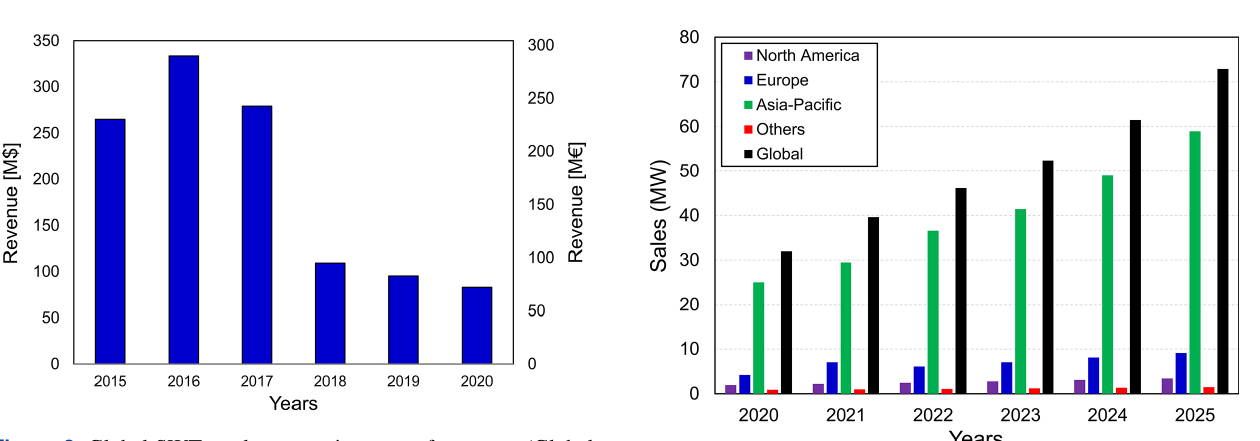
Figure 3. Global SWT market status in terms of revenues (Global Info Research, 2021). Figure 4. Global SWT sales forecast by region (2020–2025). Data from Global Info Research